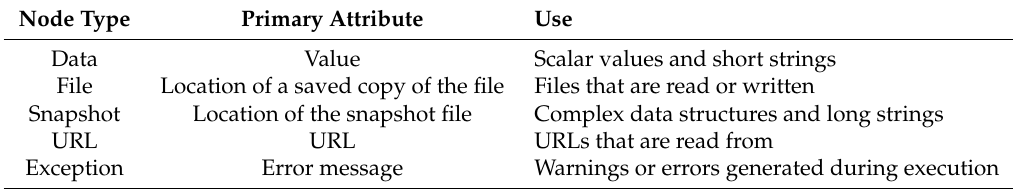
Table 1. Data node types.